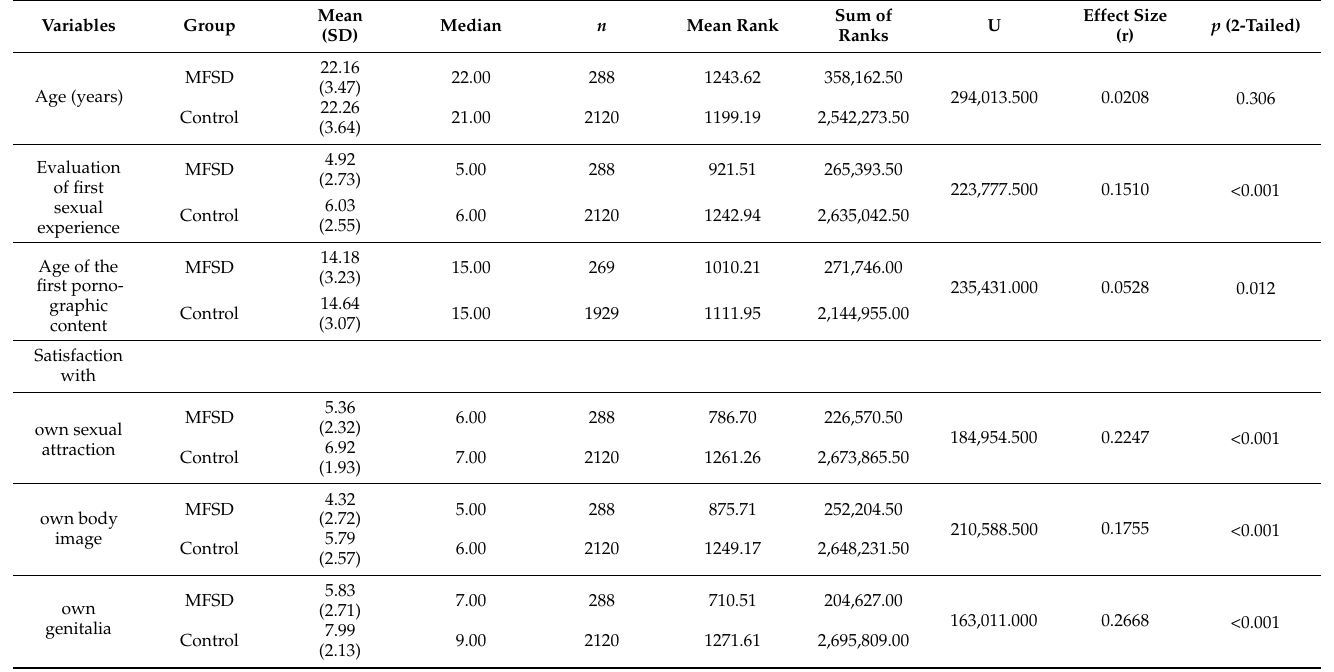
Table 5. Differences between the MFSD group and control group in sexual experience, age of first pornographic content, and